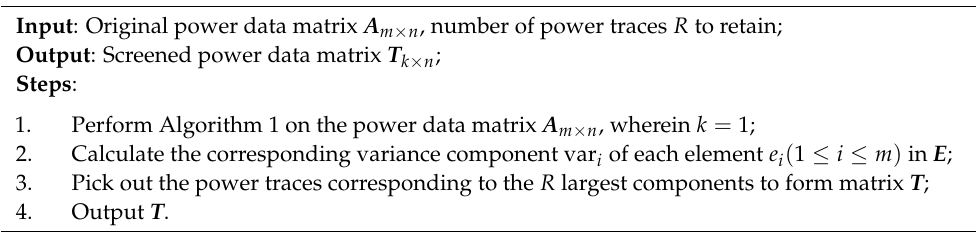
Algorithm 2 Power traces screening algorithm based on PCA